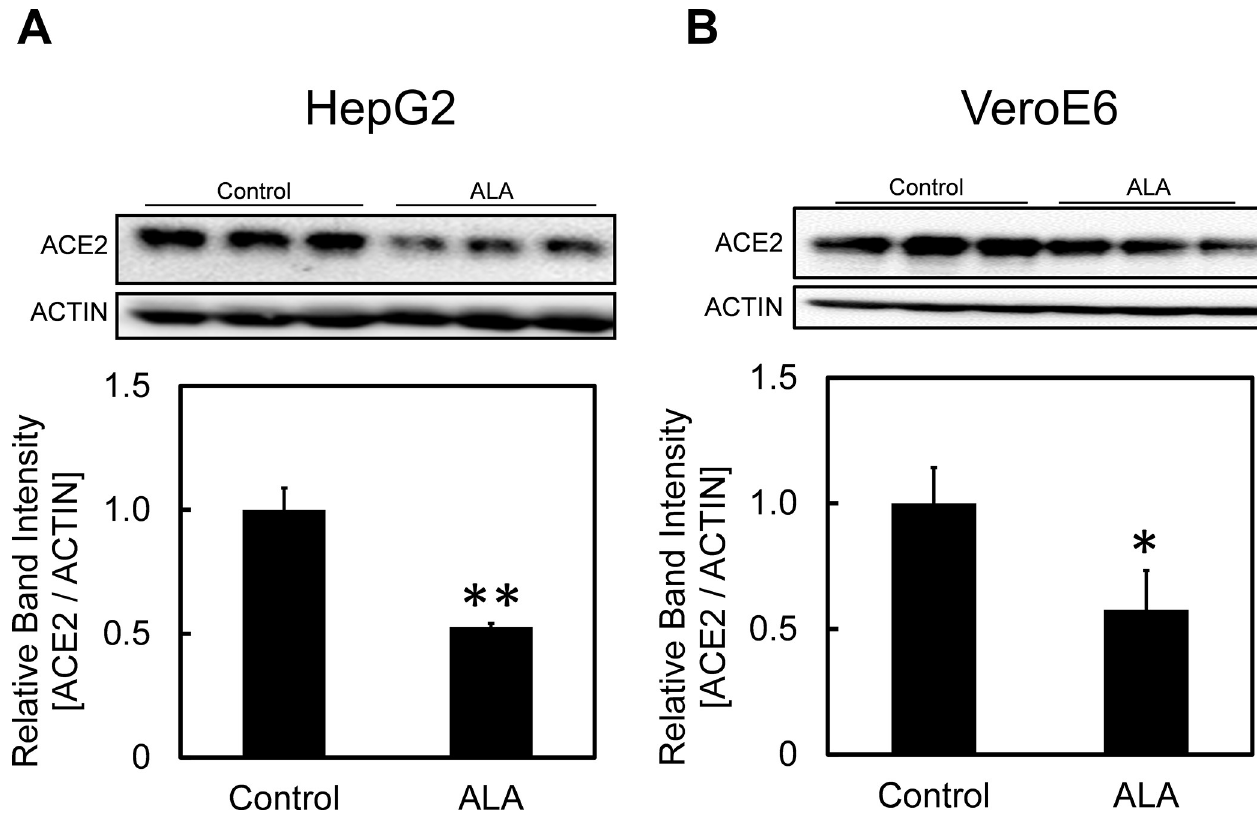
Fig 2. Effect of ALA on ACE2 expression in HepG2 and VeroE6 cells. Changes in protein expression levels of ACE2 in (A) HepG2 and (B) VeroE6 cell lines in the presence or absence of ALA treatment. A one-way ANOVA (Tukey’s test) was performed for each data set to identify differences in mean values between treated and untreated samples; �� , p < 0.01; � , p < 0.05. n = 3. Bars represent standard deviation (SD). Blots are cropped to ease visualization. Unprocessed original blot scans are shown in S1 Fig.